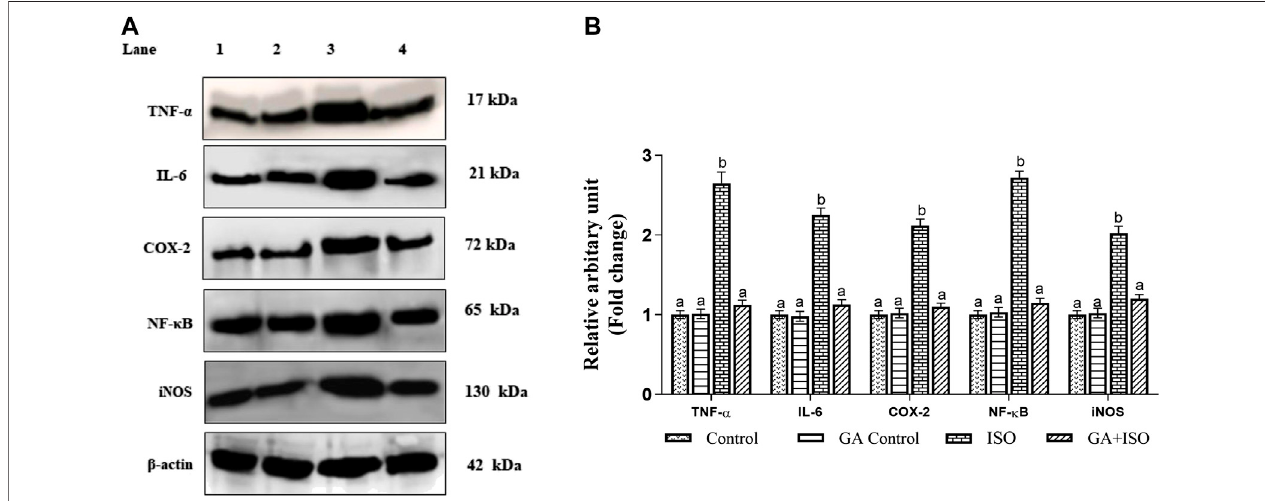
FIGURE5| EffectofGAonTNF- α ,IL-6,NF- ҡ B,COX-2andiNOSexpressioninthehearttissueofcontrolandISO-treatedrats. (A) Westernblotwascarriedoutfor theanalysisofTNF- α ,IL-6,NF- ҡ B,COX-2andiNOSexpressionandimageswereacquiredbyLI-CORusingchemiluminescencesubstrate.Lane1.Control;Lane2.GA control; Lane 3. ISO Control; Lane 4. GA + ISO. (B) The quanti fi cation of protein was performed by densitometric analysis using Image-studio software (LI-COR, United States).Thedensitometry datarepresent means ± SDfromthreeimmunoblots andareshownastherelativedensityofproteinbandsnormalized to ß -actin.Values not sharing a common superscript (a, b, C .) and differ signi fi cantly at p < 0.05 (DMRT).